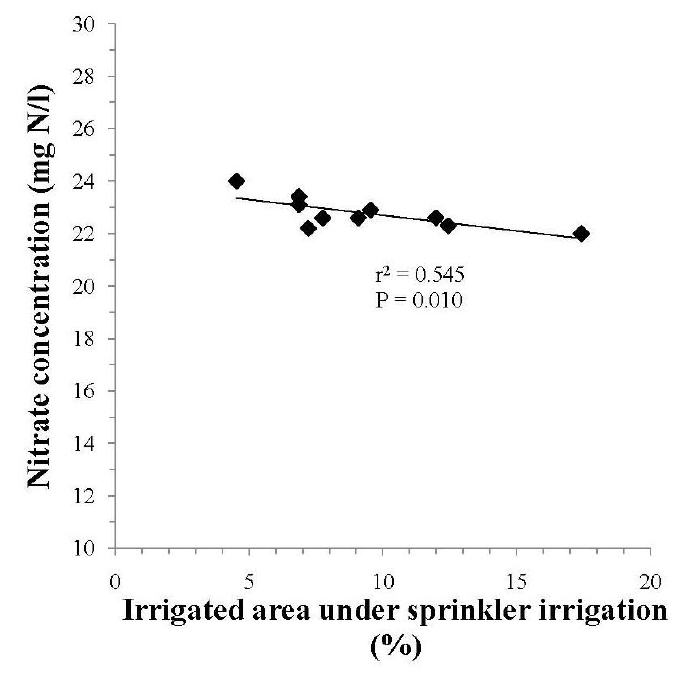
FIGURE 6. Relationship between groundwater nitrate concentrations in the primary aquifer and percentage of sprinkler-irrigated acres on the